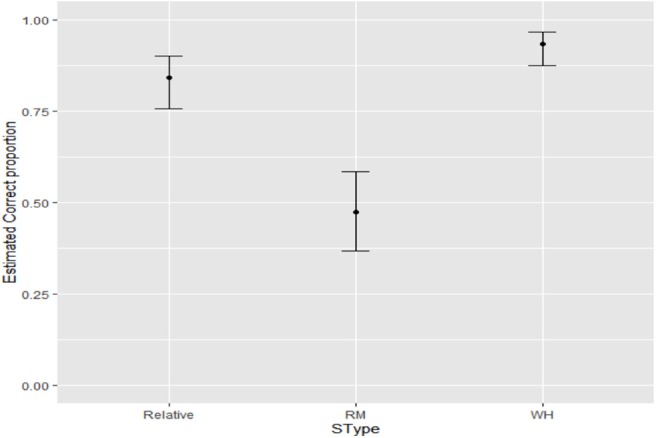
Estimated acceptance of the three sentence types.